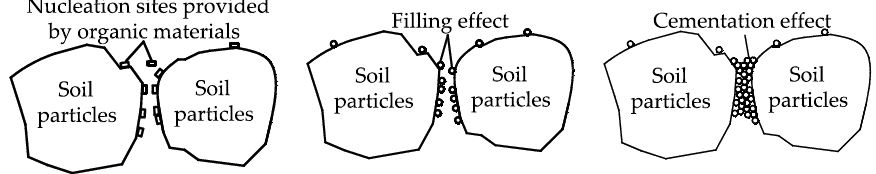
Figure 16. Mechanism of soil solidification by EICP combined with organic materials.